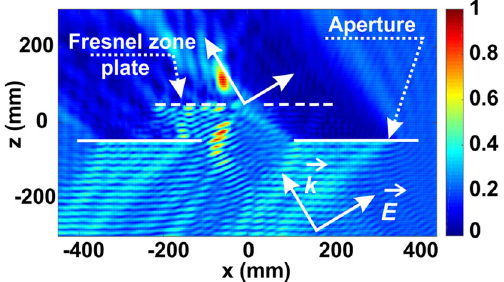
Figure 4. xz-plane cross-sections the normalized field amplitude for (θ, φ) = (32, 180)°.